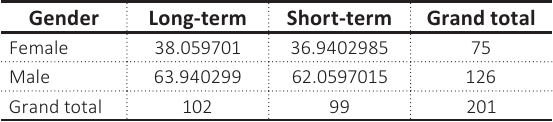
Table 1. Expected frequencies of the impact